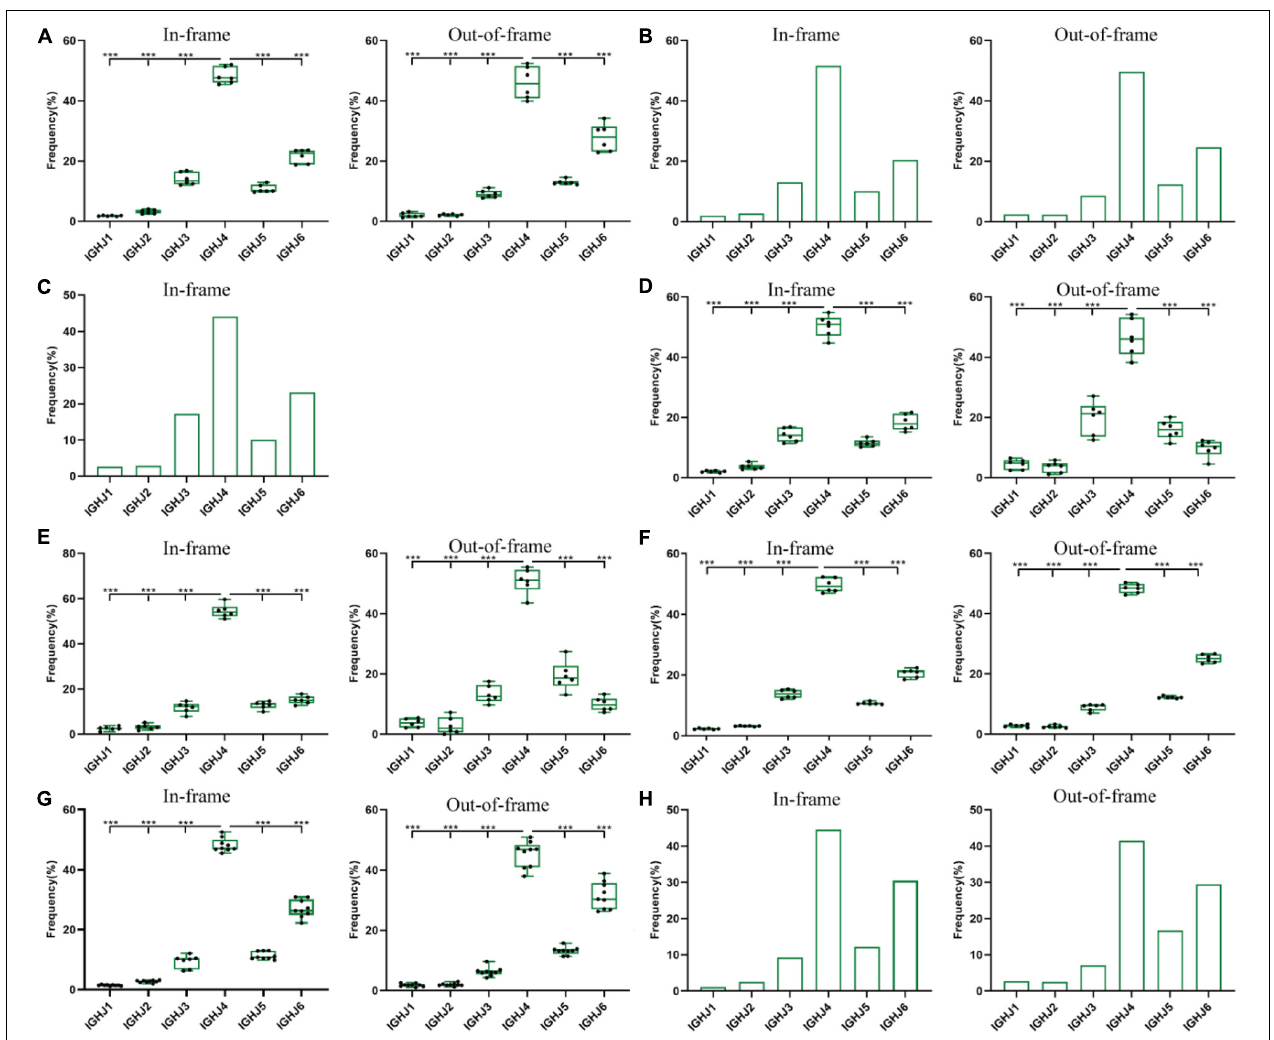
FIGURE 1 | The usage frequencies of 6 IGHJ genes in the in-frame and out-of-frame BCR-H repertoire from different subjects. (A) The IGHJ usages of BCR-H repertoire from 6 Healthy volunteers. (B) The IGHJ usages of BCR-H repertoire from public data. (C) The IGHJ usages of BCR-H sequences ( n = 9430) from IMGT data. (D) The IGHJ usages of IgM-H repertoire from volunteers before and after immunization with the HBV vaccine. (E) The IGHJ usages of IgG-H repertoire from volunteers before and after immunization with the HBV vaccine. (F) The IGHJ usages of BCR-H repertoire from SLE volunteers. (G) The IGHJ usages of BCR-H repertoire from breast cancer volunteers. (H) The IGHJ usages of BCR-H repertoire from volunteers with a high titer of HbsAb. We used bar chart for data of sample groups with n = 2 (B,H) and IMGT (C) , while used box plot for data of sample groups with n ≥ 3 by a one-way ANOVA with Bonferroni correction (A,D–G) . All statistically significant differences are indicated as * p < 0.05; ** p < 0.01, and *** p < 0.001.